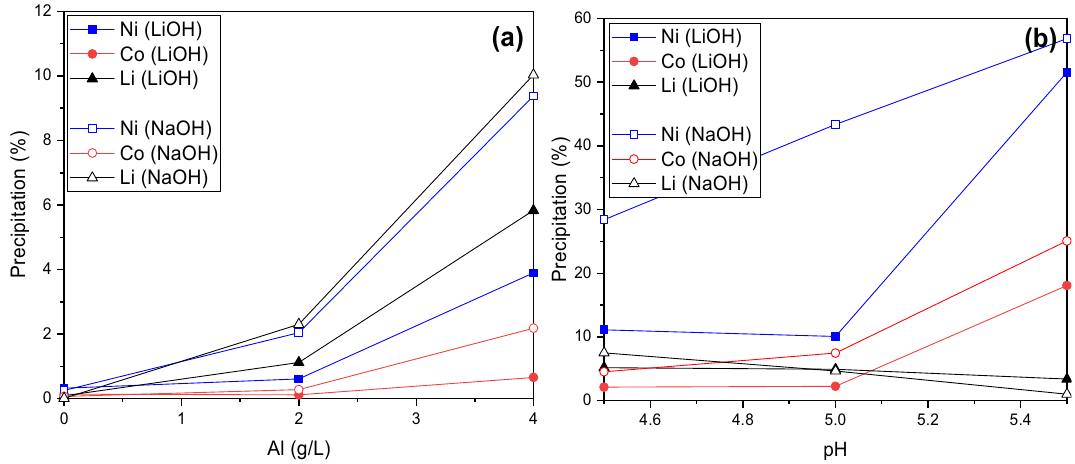
Figure 4. Precipitation of Ni, Co and Li ( a ) as a function of Al concentration (0, 2, 4 g/L) in the solution (pH 4) and ( b ) as a function of pH (4 g/L of Al) at 60